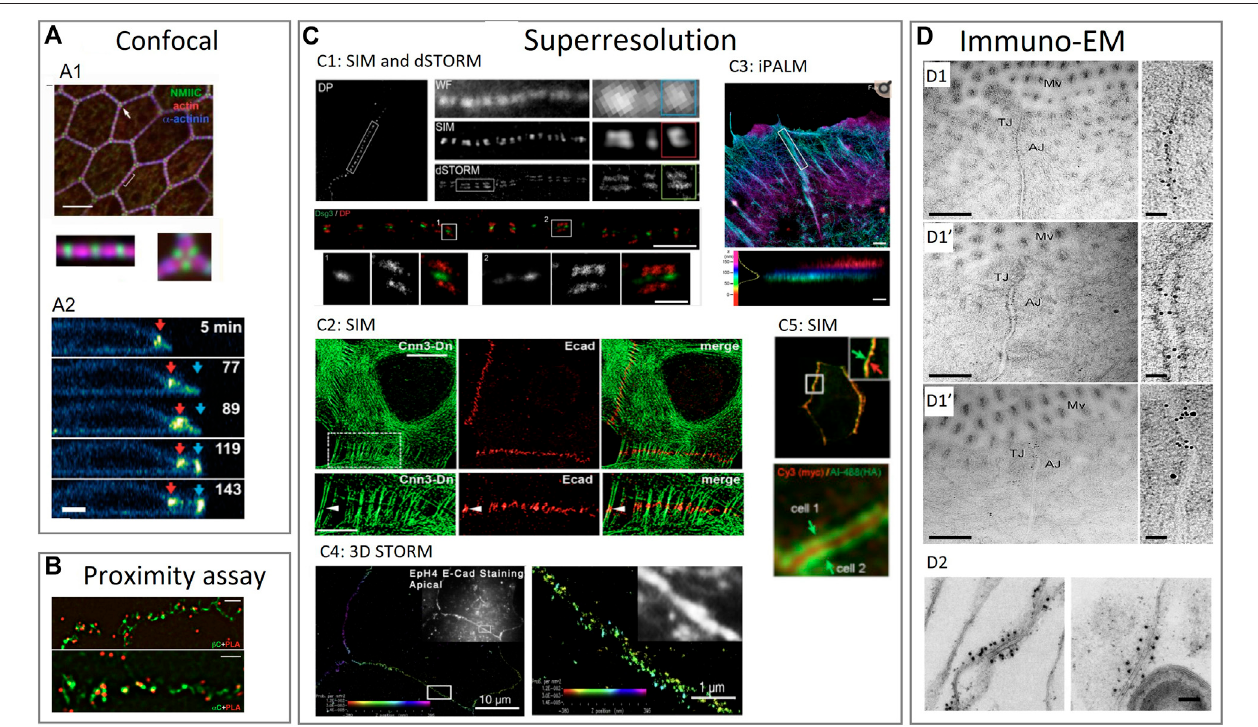
FIGURE 3 | Examples of using various imaging techniques to study the composition of intercellular junctions. (A) Confocal imaging techniques to study the compositionoftightjunctions,adherensjunctionsanddesmosomes. (A1) :Confocalimagingofapicalcelljunctionsandtheactinnetworkaroundit.Actinand α -actinin1 co-localization and the alternation with non-muscle myosin II-C (NMIIC). Fluorescent intensity (FI) pro fi le of NMIIC, actin and α -actinin was presented (Ebrahim et al., 2013). (A2) : Confocal imaging of desmosomes during apoptosis. Transverse view of a neighboring cell showing desmosomal junction dynamics during apoptotic cell extrusion. Red and blue arrows indicate pre-existing and de novo desmosomal junctions (Thomas et al., 2020). (B) Proximity assay techniques to study the composition of tight junctions, adherens junctions and desmosomes. Proximity ligation assay (PLA) in epithelial cells to determine the localization of adherens junction proteins. Cells stained with anti- β -catenin or anti- α -catenin mouse antibodies were imaged by structured illumination microscopy (SIM) super-resolution microscopy (Indra et al., 2013). (C) Superresolution imaging techniques to study the composition of tight junctions, adherens junctions and desmosomes. (C1) : SIM and dSTORM imaging of desmoplakin and desmoglein proteins in desmosomes. Upper part: SIM image of desmoplakin cell border. Region also imaged with WF (wide fi eld) microscopy, SIM and dSTORM. Bottom part: dSTORM image of keratinocyte cell-cell border labeled for the desmoglein-3 (Dsg3) N terminal (green) and desmoplakin C-terminal (red) domains (Stahley S. N. et al., 2016). (C2) : Localization of E-cadherin with actin visible by SIM. SIM of A431 cells expressing actin binding protein (calponin3) and double-stained for E-cadherin to show locations of punctate adherens junctions (Indra et al., 2020). (C3) : interferometric photoactivated localization microscopy ( iPALM) imaging of F-actin in epithelials cells. F-actin is labeled with phalloidin. Colors indicate the vertical (z) coordinate, relative to the substrate surface (Bertocchi et al., 2017). (C4) : 3D STORM image of apical cell-cell junctions between Eph4 cells shows E-cadherin staining. In all 3D-STORM images, the z position is color coded, and intensity indicates position accuracy according to the color bar in each panel (Wu et al., 2015). (C5) : Cells expressing exogenous ZO-1 labeled on the N-terminusandontheC-terminusmadevisiblebySIM.Upperpanel:exogenousZO-1targetedtojunctions.Lowerpanel:centralN-terminal(red)labeledregion fl anked by two C-terminal (green) labeled regions of ZO-1, corresponding to a mirror-like arrangement of ZO-1 molecules on two sides (Spadaro et al., 2017). (D) Immuno- electronmicroscopyimagingtechniquestostudythecompositionoftightjunctions,adherensjunctionsanddesmosomes. (D1) :Immunoelectronmicroscopy(immuno- EM) images double labeled with immunogold for different tight and adherens junction proteins. Enterocyte tissue of normal mice with occludin labelled with 10 nm gold which localizes mainly at the tight junctions (D1) , calveolin-1 labelled with 10 nm gold which localizes mainly at the adherens junctions (D1 ’ ) and occludin labelled with 10 nm gold and calveolin with 15 nm gold to see the latter in both the adherens and tight junctions while occluding only occurs at the tight junction (D1 ’’ ) (Marchiando et al., 2010). (D2) : Immuno-EM of isolated chick liver tissue to show the tight junction protein occluding labelled with 10 nm gold particle. The tight junction strand is cut traverse and many gold particles are aligned longitudinal to the cut (Furuse et al., 1993). Reproduced/adapted with